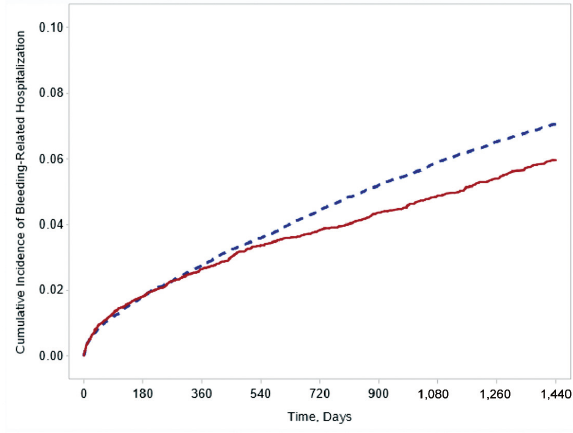
Fig. 3 Kaplan – Meier curve for bleeding-related hospitalization. red/solid line represents rivaroxaban; blue/dashed line represents warfarin.